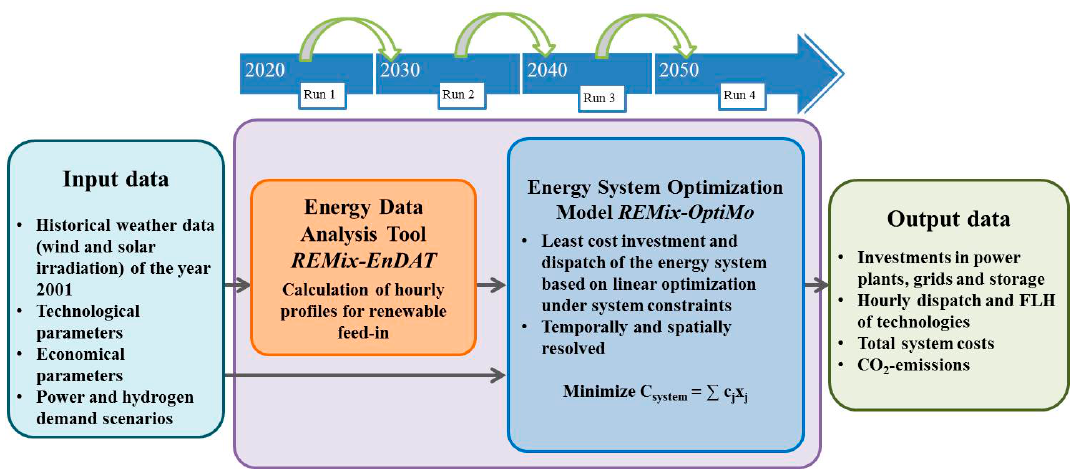
Figure 2. Renewable Energy Mix (REMix) energy system model based on [17] and its application in this study.